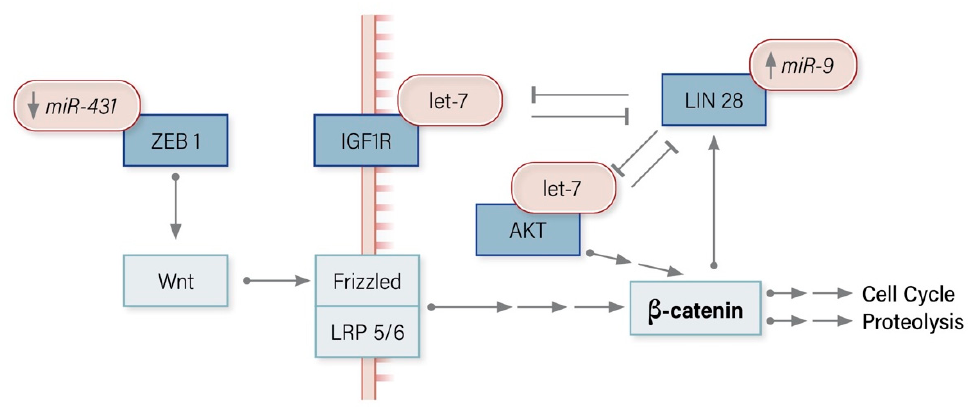
Figure 3. miRNA modulators of the Wnt/ β-catenin signaling pathway in Adrenocortical Carcinoma.